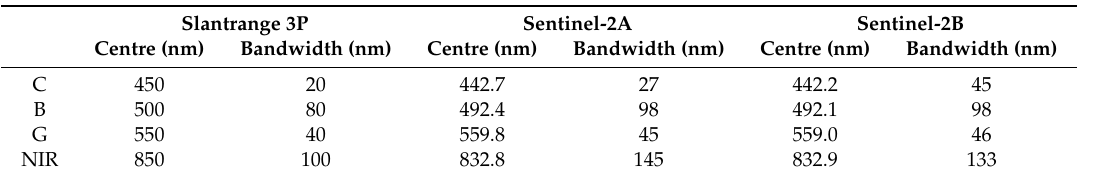
Table 1. Waveband information for the Slantrange 3P imager and Sentinel-2 missions. Coastal (C), blue (B), green (G), and near-infrared (NIR).